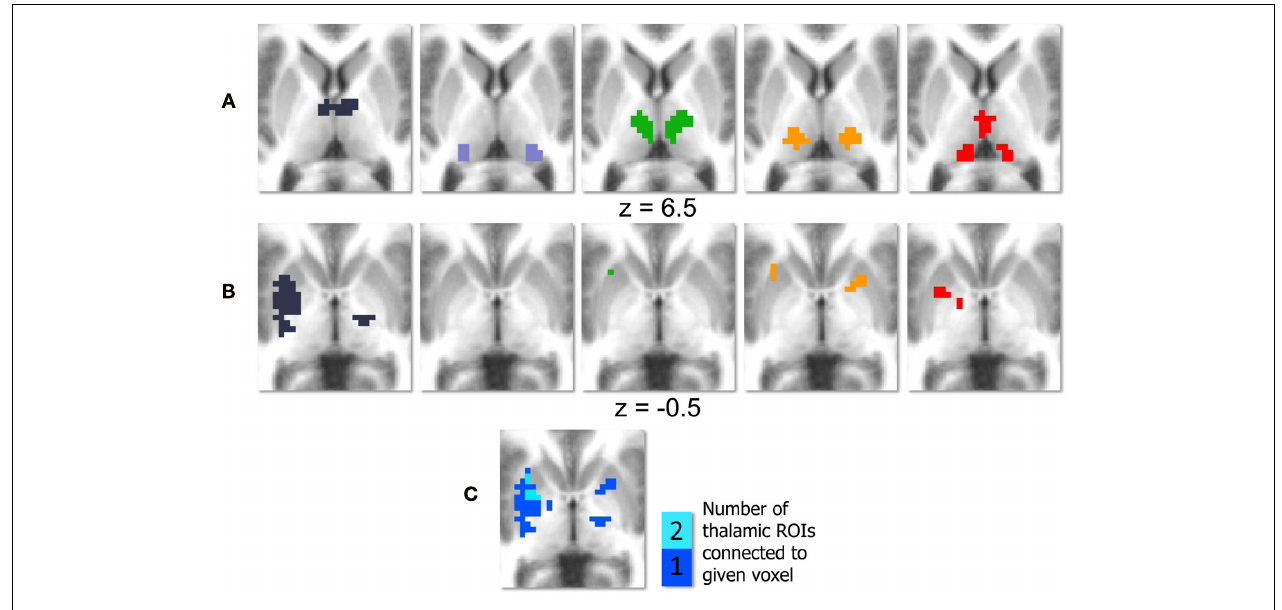
temporal thalamic ROI. Regions of the basal ganglia that survive the conjunction analysis are displayed in row (B) , with each column corresponding to one thalamic ROI.The colors in (C) indicate how many thalamic ROIs show significant connections that pass the conjunction analysis with a given area of the basal